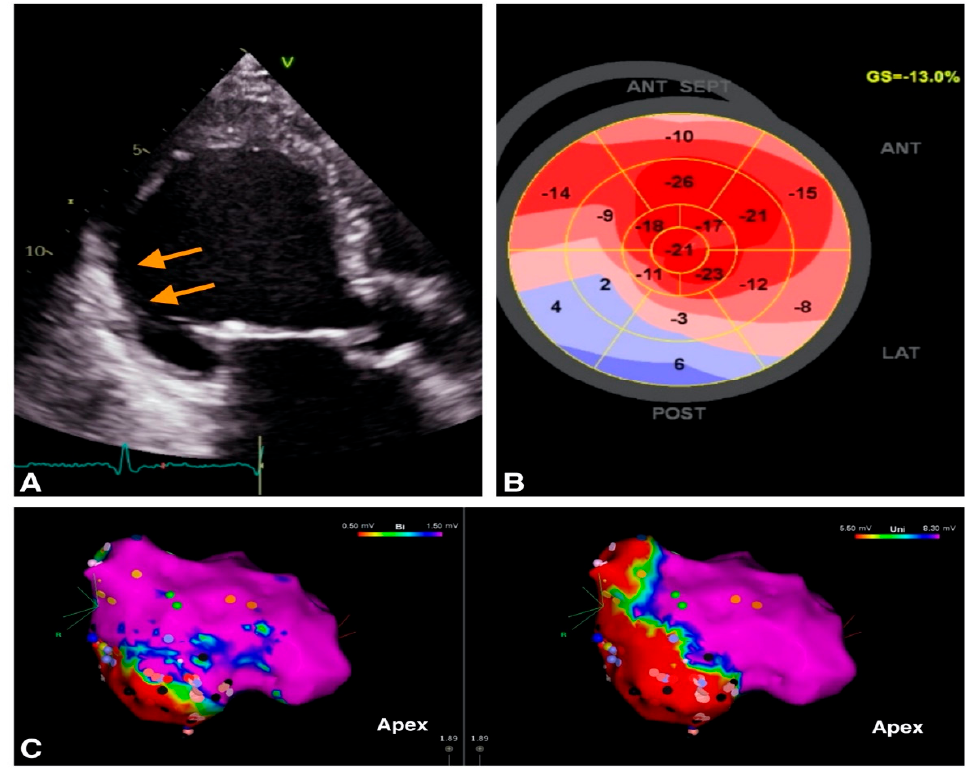
Figure 1. Example of image integration from a patient with VT and old myocardial infarction; ( A ). 2D apical 3 chambers view showing the thin, hyperechogenic inferolateral wall (orange arrows). ( B ). Bull’s eye representation of peak longitudinal strain showing positive values in inferior wall providing a description of the myocardial scar ( C ) Electroanatomic bipolar (left) and unipolar (right) voltage maps in septal view, with an inferior area of low voltage corresponding to the scar identified by echocardiography.